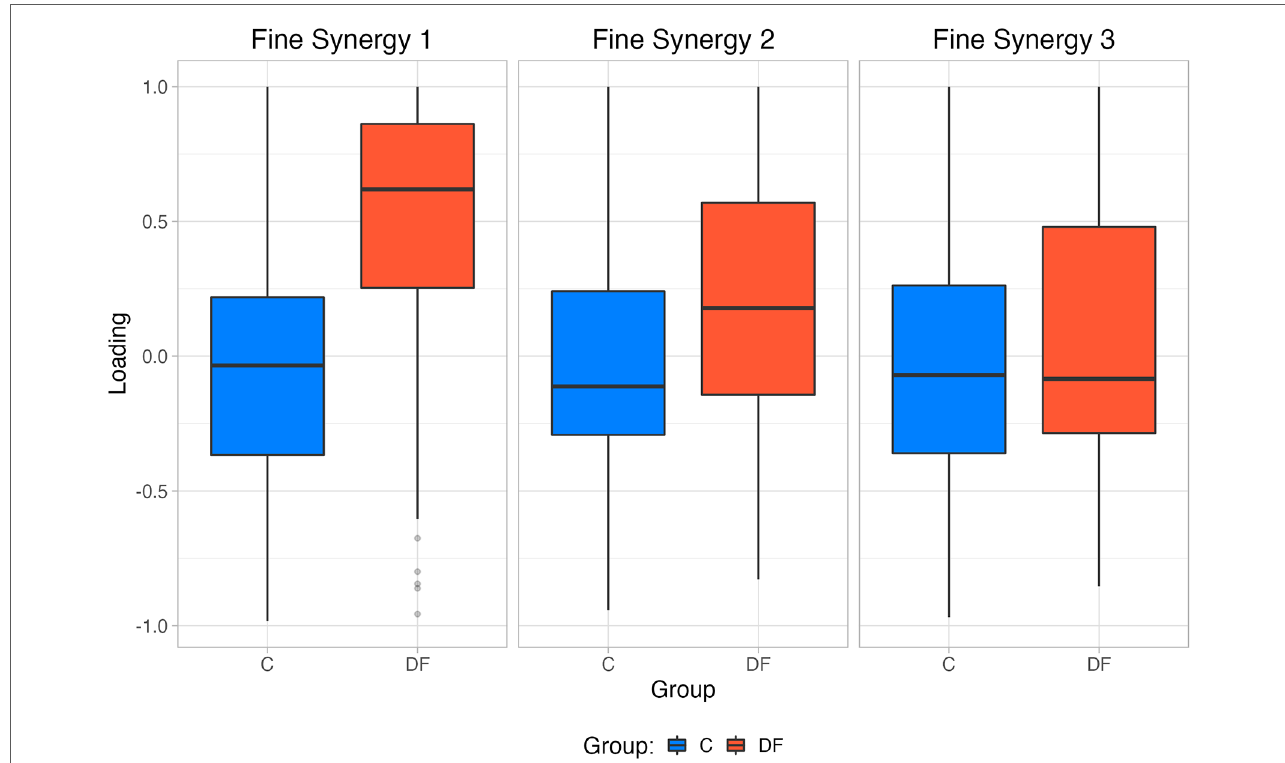
FIGURE 5 Mean Fine synergy loadings for each group extracted by